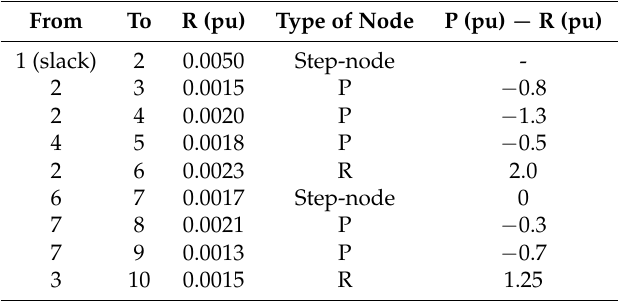
Table 1. Electrical parameters of the 10 bus test